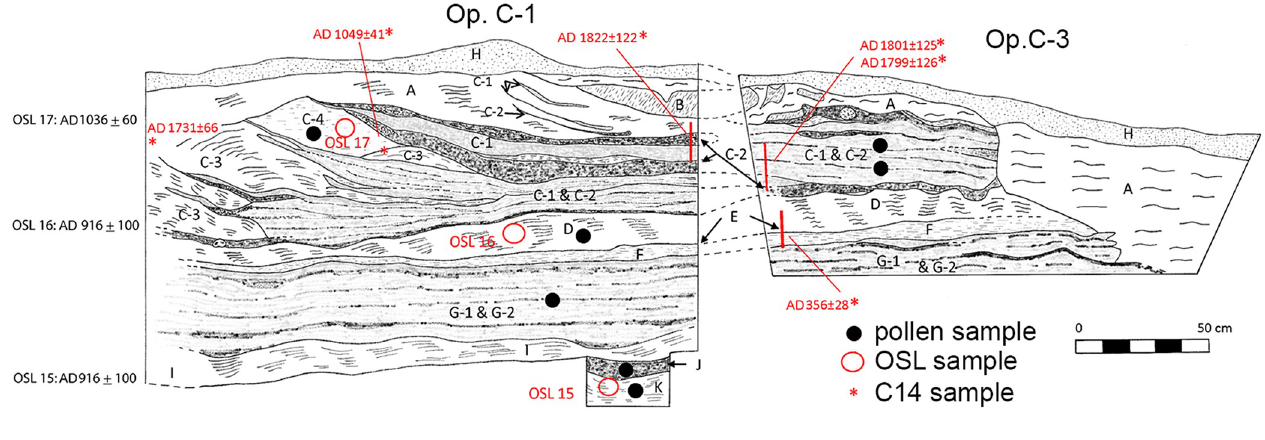
Fig 3. Stratigraphic profiles of Operations C-1 and C-3. (Image created by David Lentz. Reprinted from [19] under a CC BY license, with permission from Vernon L. Scarborough, original copyright 2018).